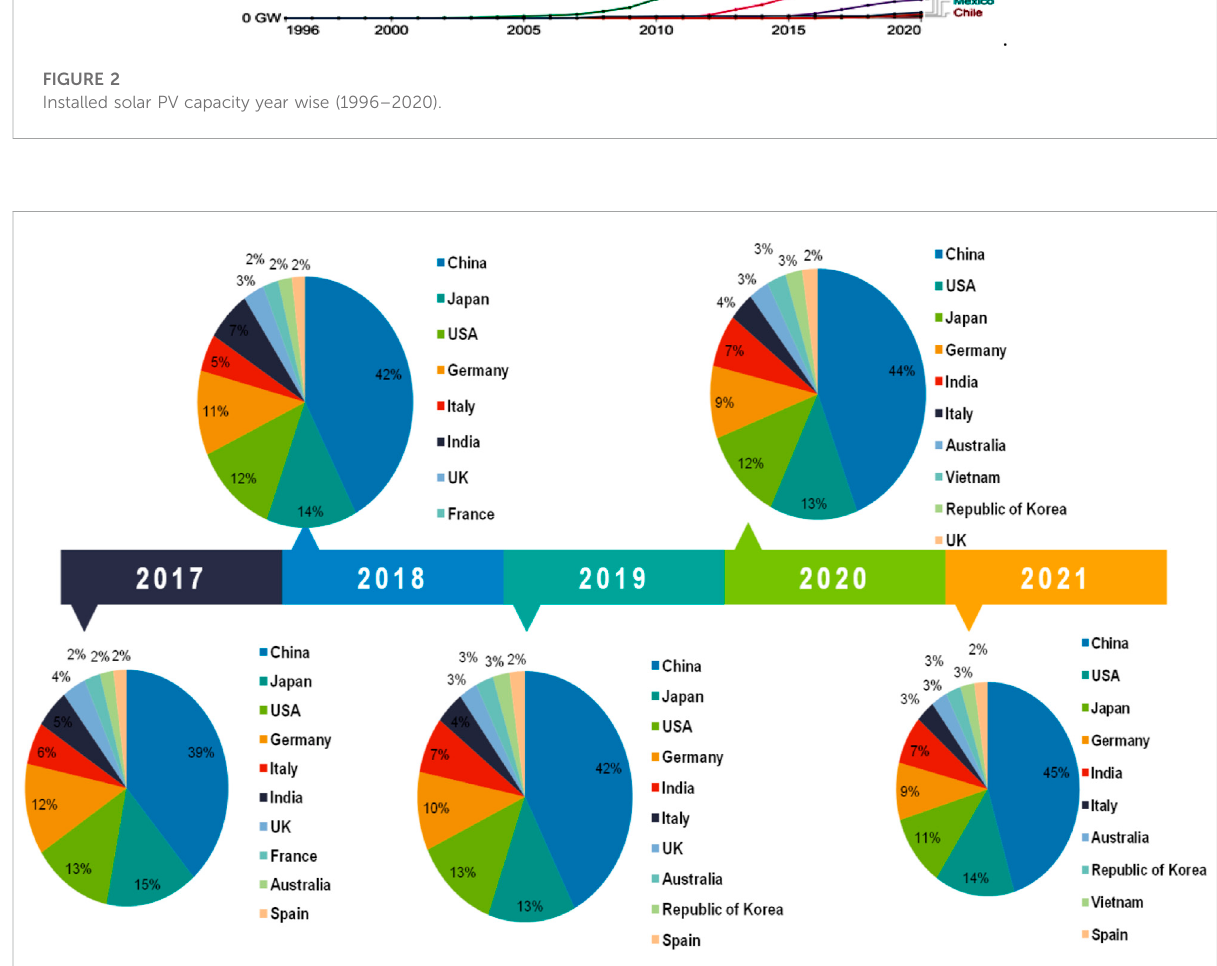
FIGURE 3 Milestone for solar installed capacity by different countries year